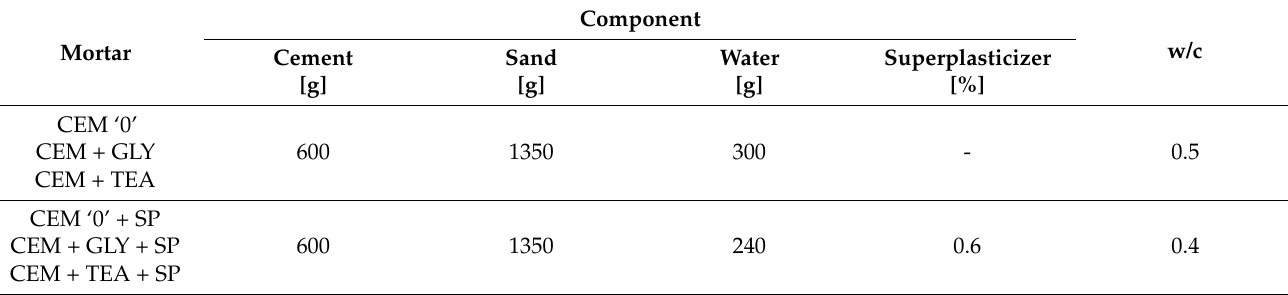
Table 3. Composition of mortars for consistency and strength evaluations.